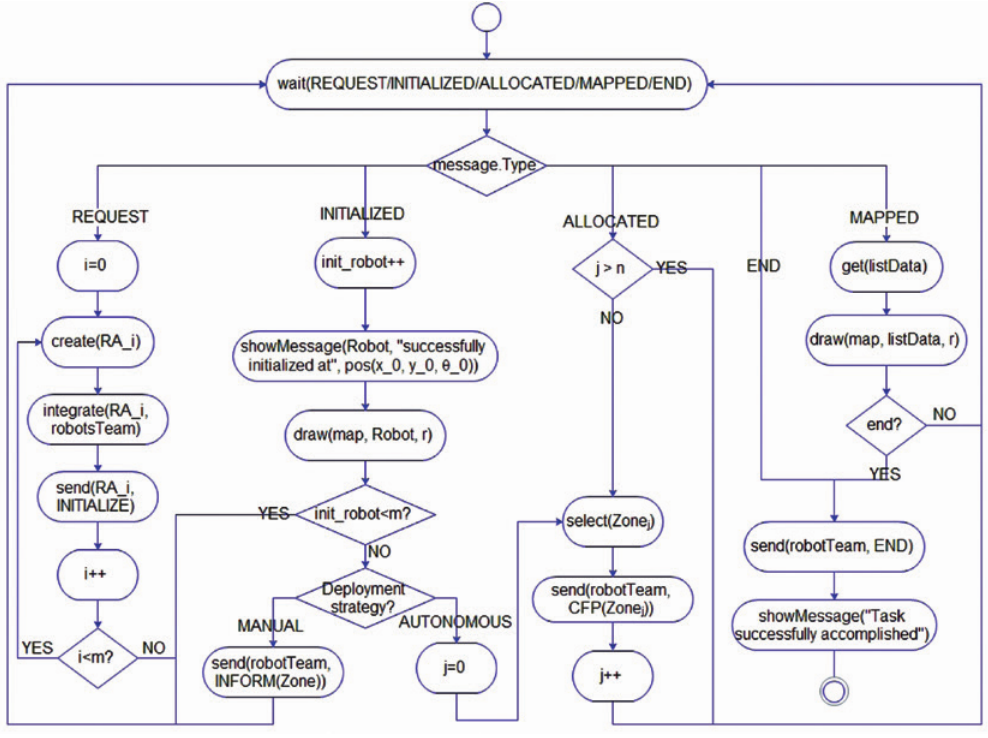
Figure 3: Behavior Diagram of the Human/Machine Interface Agent (HMIA)